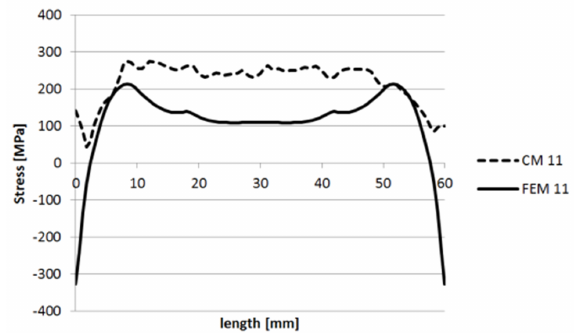
Figure 25. Stress levels in 11 direction along the AB line segment.